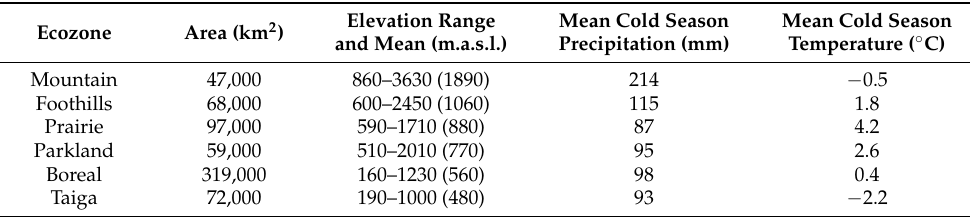
Table 1. Area, elevation, and mean cold season (November–April) climate (1950–2017) for the six